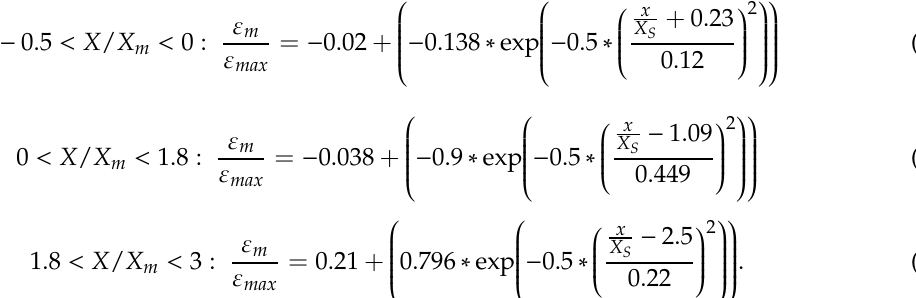
Figure 9. Dimensionless scour section of different zones. ( a ) Small scour hole ( ‐ 0.5 < X/X m < 0); ( b ) primary scour hole (0 < X/X m < 1.8); ( c ) deposition dune (1.8 < X/X m < 3). The entire scour profile can be predicted by using Equations (5)–(7).